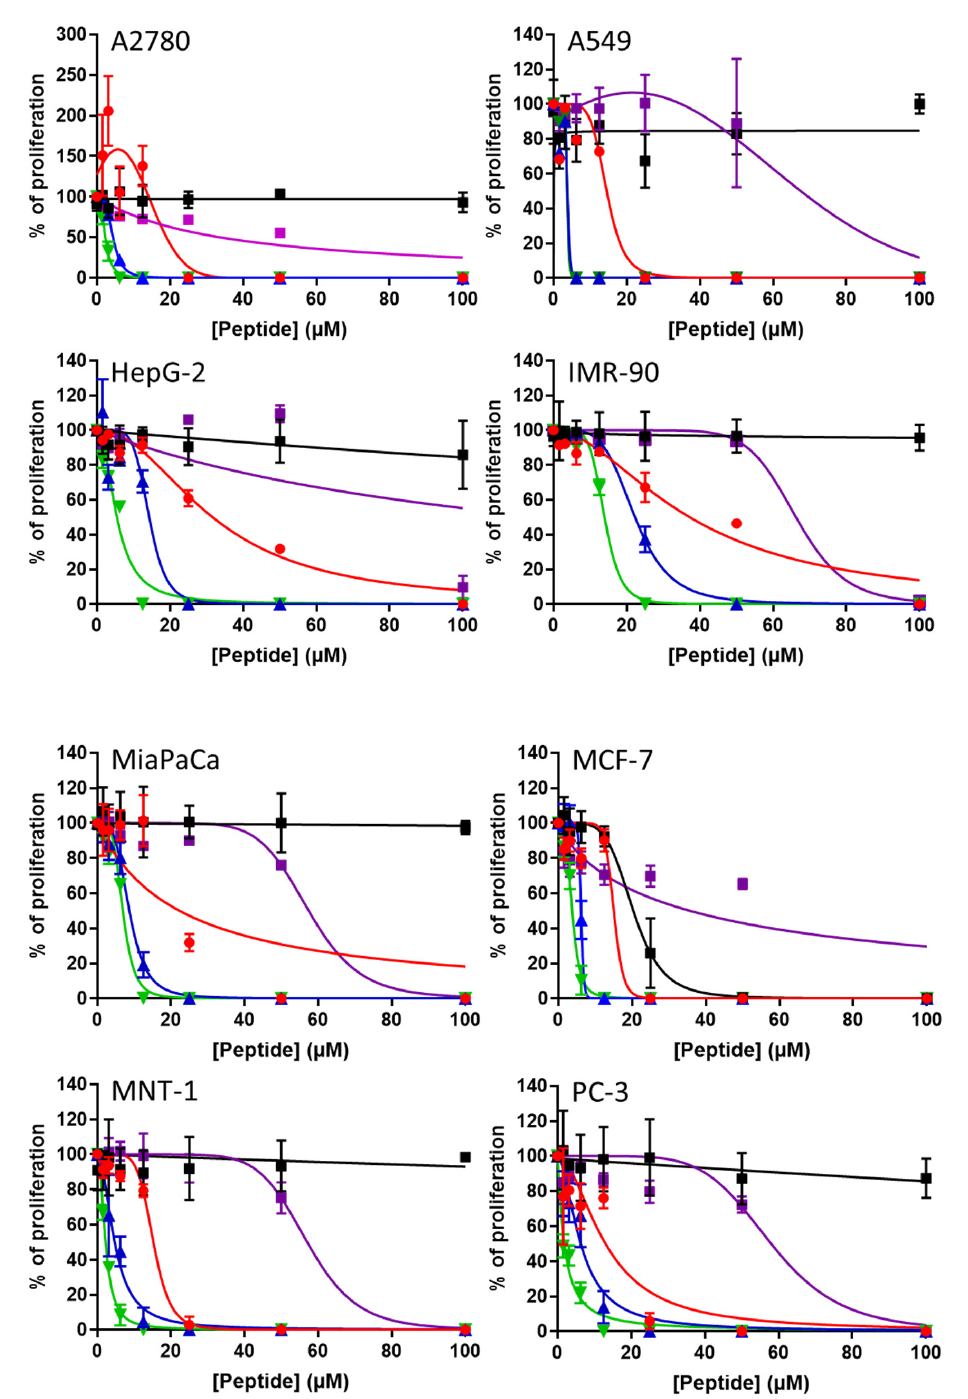
Figure 8. Antiproliferative effect of SHa, [G10a]-SHa and its dendrimers on human cancer cells. Proliferation of human cells over 48 h was measured in the presence of increasing concentrations of SHa (black squares), [G10a]-SHa (red circles), [G10a] 2 -SHa (blue triangles), [G10a] 3 -SHa (green inverted triangles) or Jeff-[G10a] 2 -SHa (purple squares). Proliferation was expressed as percentage of untreated control cells (means ± SD, n = 3). Curves were fitted using GraphPad ® Prism 7 software.